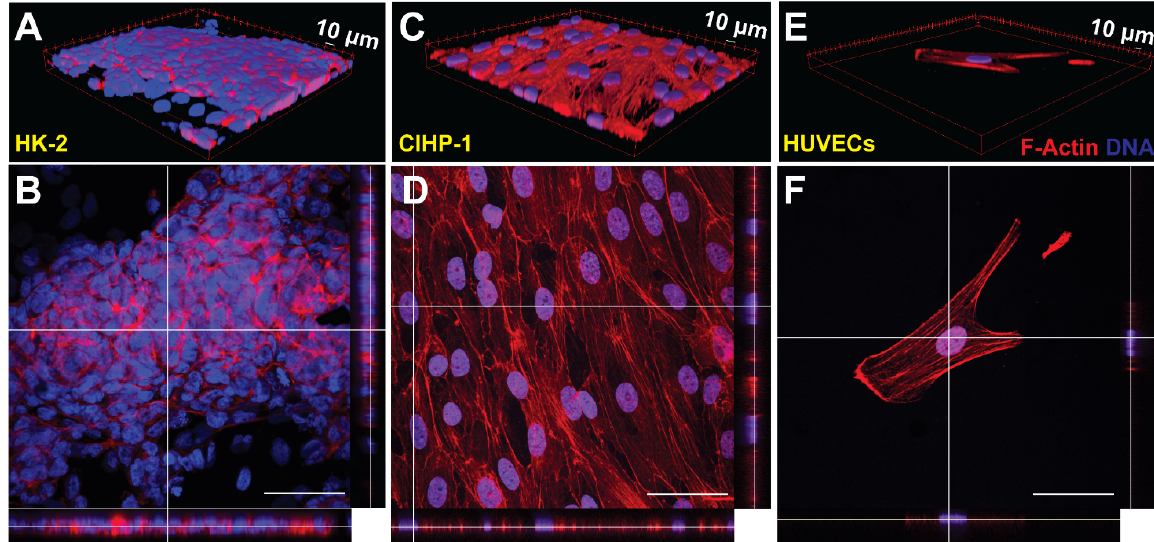
Figure 6. Post-experiment fluorescent-stained cell images ( n = 9). ( A ) 3D projection of HK-2 on polycarbonate membrane. ( B ) 2D orthogonal view of HK-2 on polycarbonate membrane. ( C ) 3D projection of CIHP-1 on PES membrane. ( D ) 2D orthogonal view of CIHP-1 on PES membrane. ( E ) 3D projection of HUVECs on PES membrane. ( F ) 2D orthogonal view of HUVECs on PES membrane. Red = Phalloidin 568, blue = Hoescht 33342, and green = FITC-HSA.